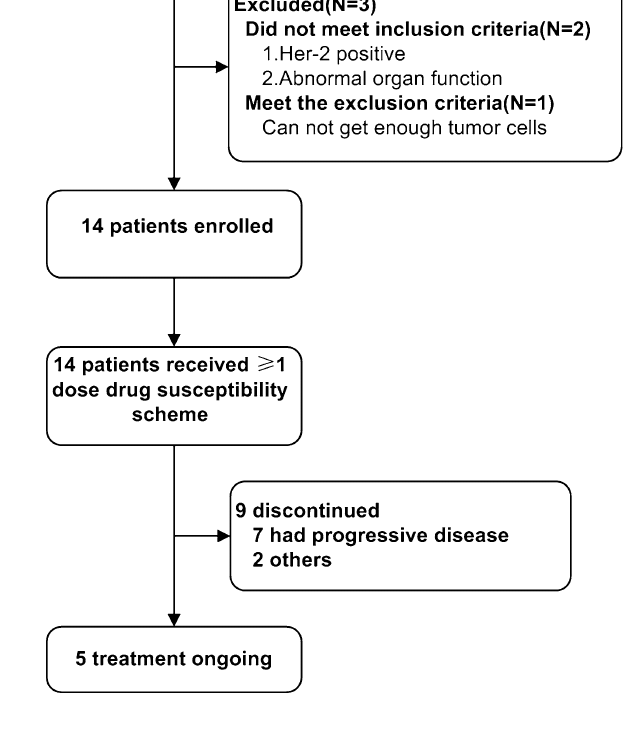
Table 2 Baseline characteristics of